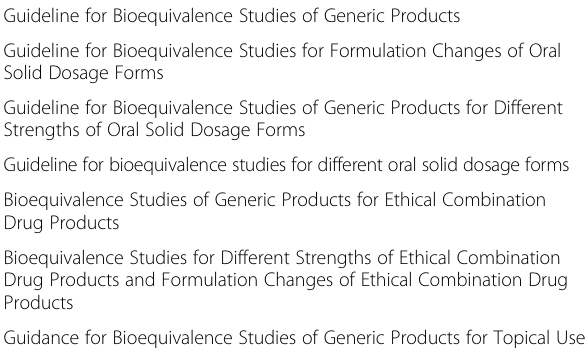
Table 1 Current set of major guidelines for bioequivalence studies in Japan (published from MHLW) Guideline for Bioequivalence Studies of Generic Products Guideline for Bioequivalence Studies for Formulation Changes of Oral Solid Dosage Forms Guideline for Bioequivalence Studies of Generic Products for Different Strengths of Oral Solid Dosage Forms Guideline for bioequivalence studies for different oral solid dosage